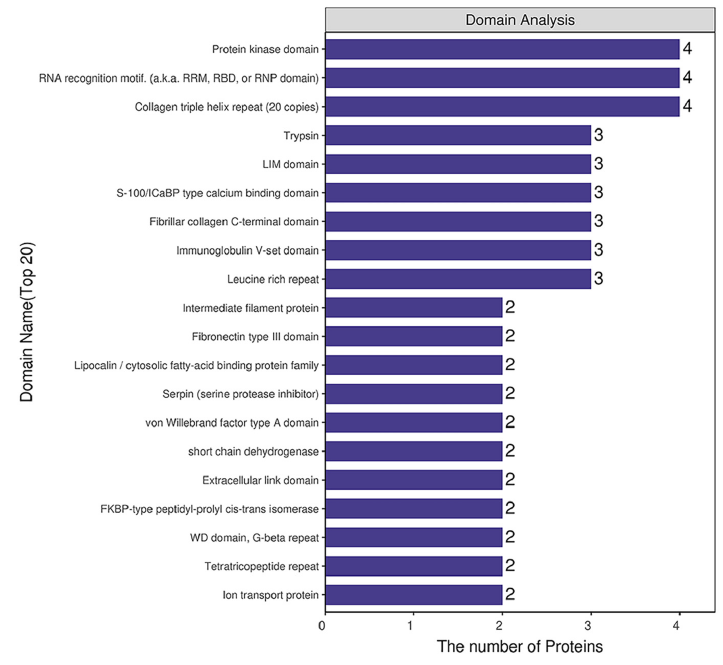
Figure 7. Structural domain analysis of DEPs.